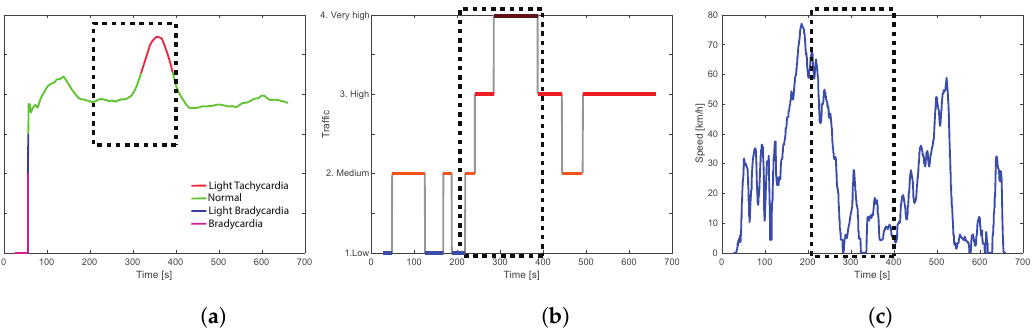
Figure 15. Heart condition results in experiment 34